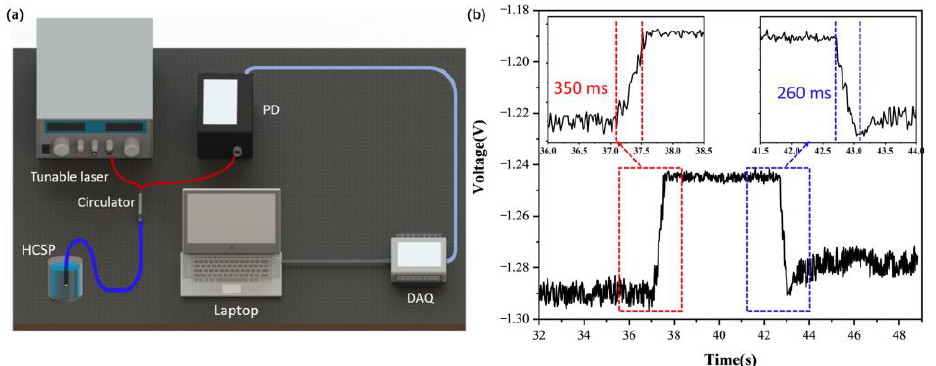
Figure 6. ( a ) The image of response time experimental setup. ( b ) The response time and recovery time of HCSP.